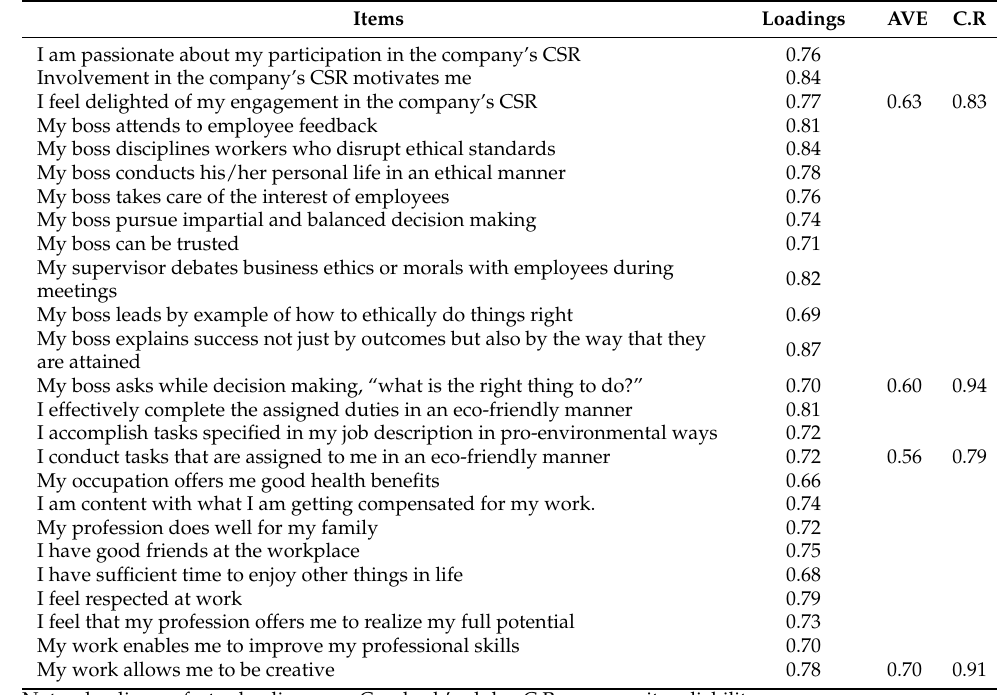
Table 2. Factor loading, convergent validity and reliability results.